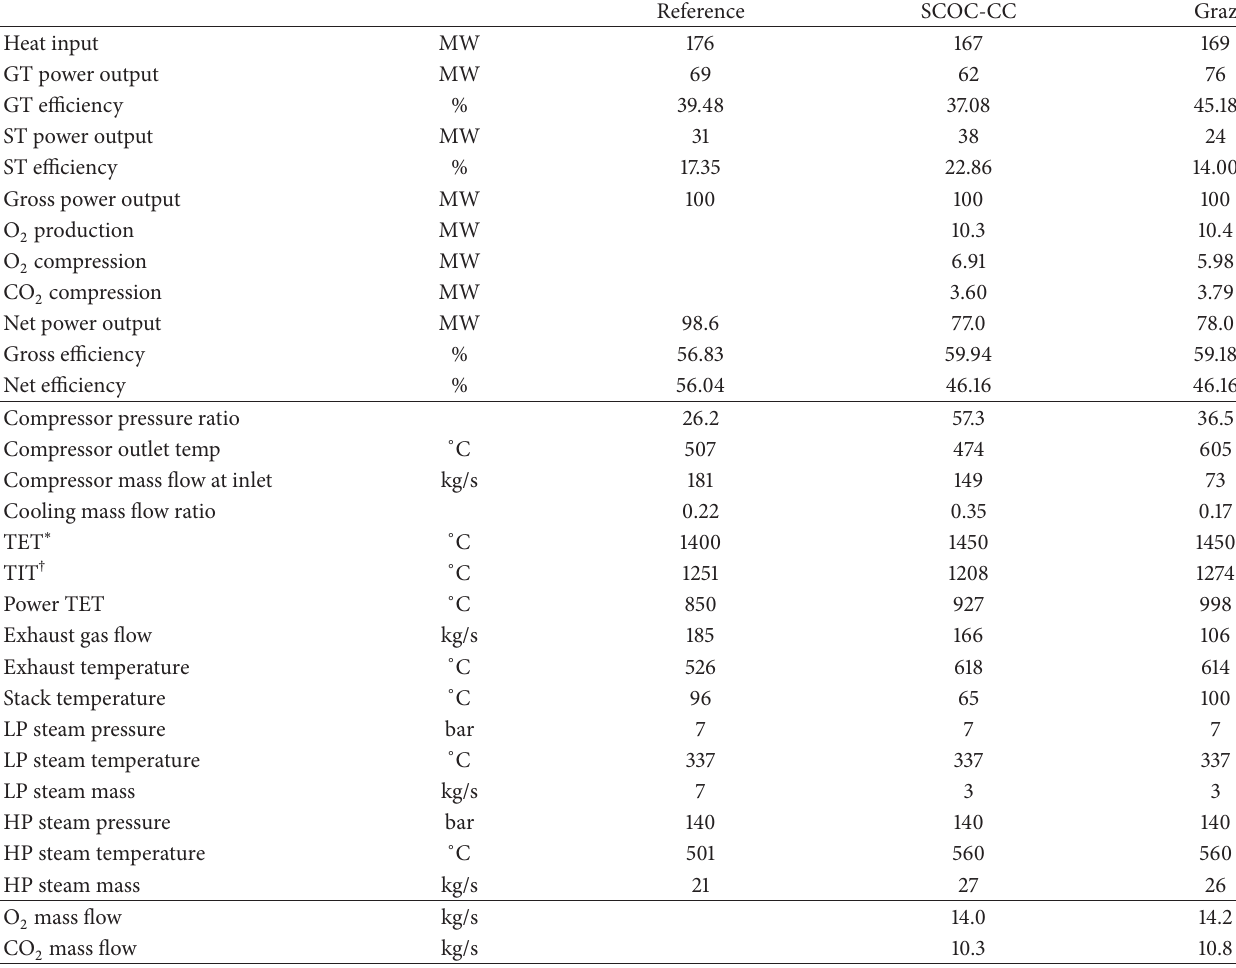
Table 7: Results for the optimal